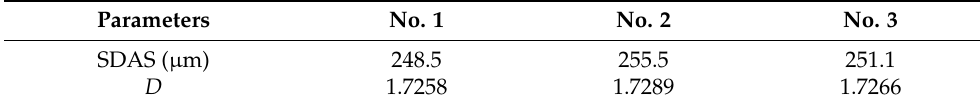
Figure 3. Solidification structures of three repeated experiments by HT-CSLM at 10 °C/min. Table 2. SDAS and fractal dimensions ( D ) of three repeated